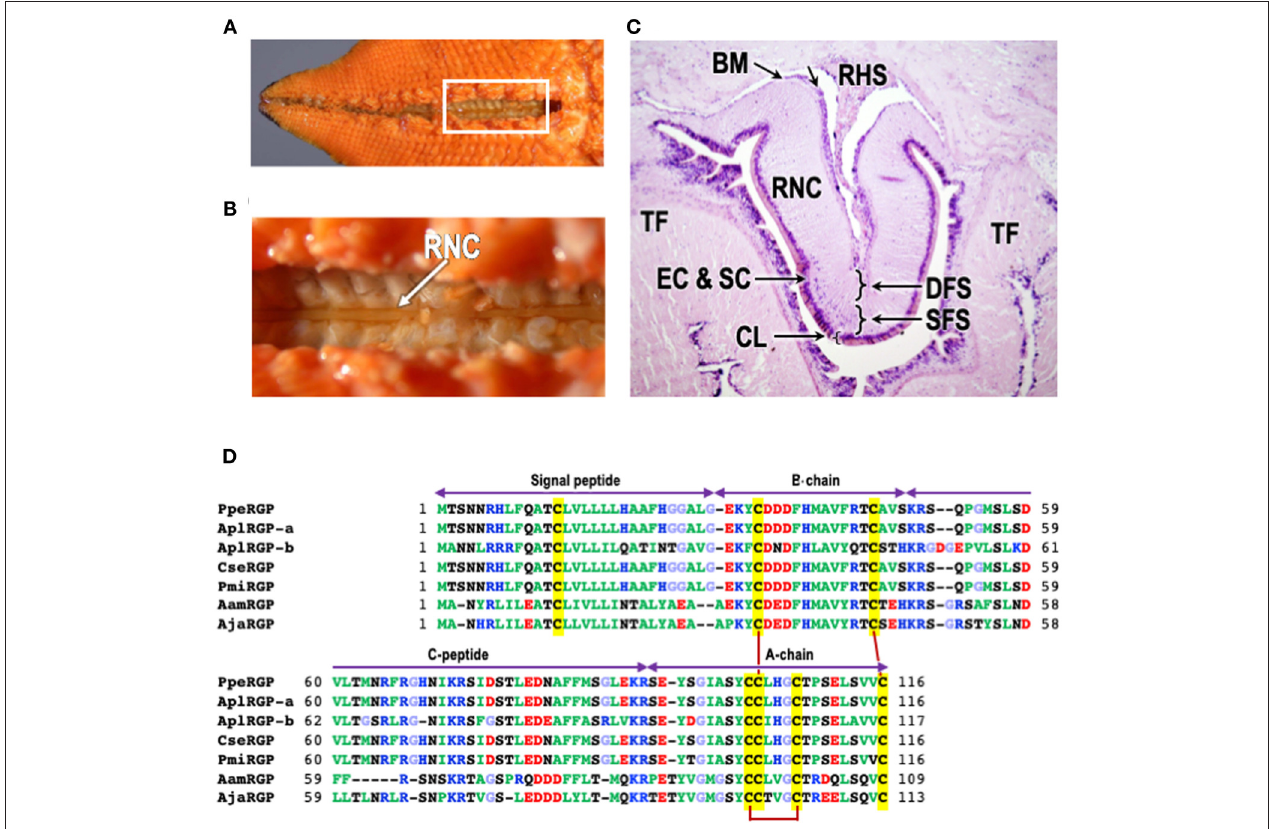
FIGURE 1 | Structure of radial nerve cords of starfish P. pectinifera and chemical structures of relaxin-like gonad-stimulating peptides (RGP) in various species of starfish. (A) Aboral surface of P. pectinifera . (B) Magnified image of the area in the square in (A) . Arrow indicates radial nerve cords. (C) Cross-section of the tissue around radial nerve cord of P. pectinifera . The specimen was stained with hematoxylin-eosin. (D) Alignment of RGP pre-prohormone sequences of P. pectinifera , Acanthaster planci (A. planci) , Certonardoa semiregularis (C. semiregularis) , P. miniata , Asterisa amurensis (A. amurensis) , and A. japonica . The signal peptide, C-peptide, B- and A-chains are indicated. To illustrate the conserved features, the amino acid types are color coded according to their nature with basic residues in blue (Arg, Lys, and His), acidic residues in red (Glu and Asp), hydrophobic residues in green (Ala, Val, Ile, Phe, Trp, Tyr, Pro, and Met), hydrophilic in black (Ser, Thr, Asn, and Gln) and glycine in light blue. The cysteine residues are highlighted in yellow, and the disulfide bonds are shown by solid dark red lines. The abbreviations and the sequence sources [DDBJ accession numbers]: AamRGP, A. amurensis RGP (LC040882); AjaRGP, A. japonica RGP (LC104980); AplRGP-a, A. planci RGP-a (LC033566); AplRGP-b, A. planci RGP-b ( 19); BM, basement membrane; CL, cuticle layer; CseRGP, C. semiregularis RGP (LC066682); CT, connective tissue; DFC, deep fiber system; EC, epithelical cells; SC, sensory cells; PmiRGP, P. miniata RGP (LC057656); PpeRGP, P. ( Asterina ) pectinifera RGP (AB496611); RHS, radial heamal sinus; RNC, radial nerve cord; SFS, superficial fiber system; and TF, tube